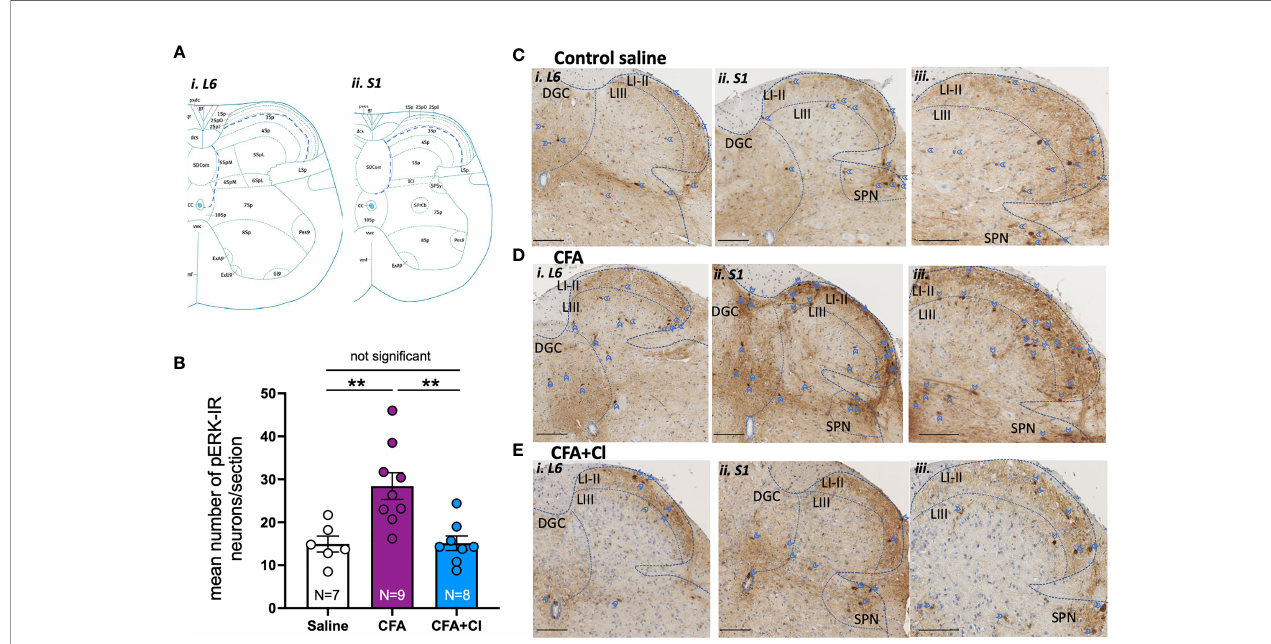
FIGURE 2 | Clodronate liposome treatment revert the CFA-induced increase in the nociceptive signalling sent to the central nervous system. (A) Schematic demonstration of dorsal horn laminae in spinal cord in cross section, demonstrating areas in which pERK-IR neurons evoked by vaginal distension were quanti fi ed within i) L6 and ii) S1 (Allen Institute for Brain Science, 2008). (B) The number of pERK immunoreactivity (pERK-IR) evoked by in vivo vaginal distension (60 mmHg) was quanti fi ed within the lumbosacral L6 and S1 spinal cord in control saline mice (clear bar), mice that had received complete Freud ’ s adjuvant (CFA; plum bar) and mice that received CFA and were treated with clodronate (CFA+Cl; blue bar). Grouped data showed a signi fi cant increase (**p < 0.01) in the number of pERK-IR neurons/section across the L6-S1 dorsal horn of the spinal cord in mice that received CFA compared to control saline mice. This increase in dorsal horn neuron activation was not observed in CFA mice treated with clodronate, with the number of pERK-IR neurons signi fi cantly (**p < 0.01) reduced in CFA-clodronate mice relative to CFA-treatment mice. ANOVA: F (2,20) = 10.20, p = 0.0009, control saline 15.0 ± 1.9; CFA 28.4 ± 3.1; CFA + clodronate 15.1 ± 1.7, data represents mean ± SEM pERK-IR neurons per section of LS spinal cord, from 5-10 sections per mouse. (C – E) Representative images of pERK-IR neurons (dark brown, blue arrow heads) in cross sections of i) L6 and ii and iii) S1 spinal cord dorsal horn from (C) Mice that received saline, (D) mice that received CFA and (E) CFA mice